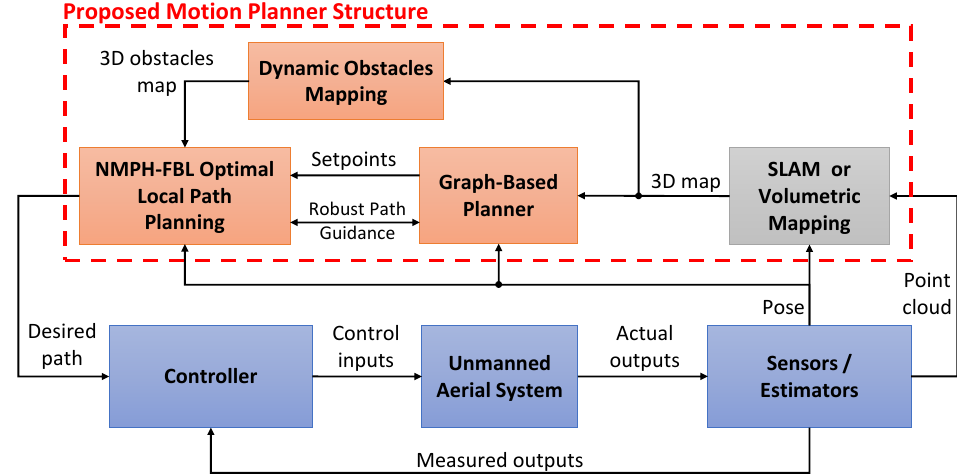
Figure 1. Block diagram of the proposed global motion